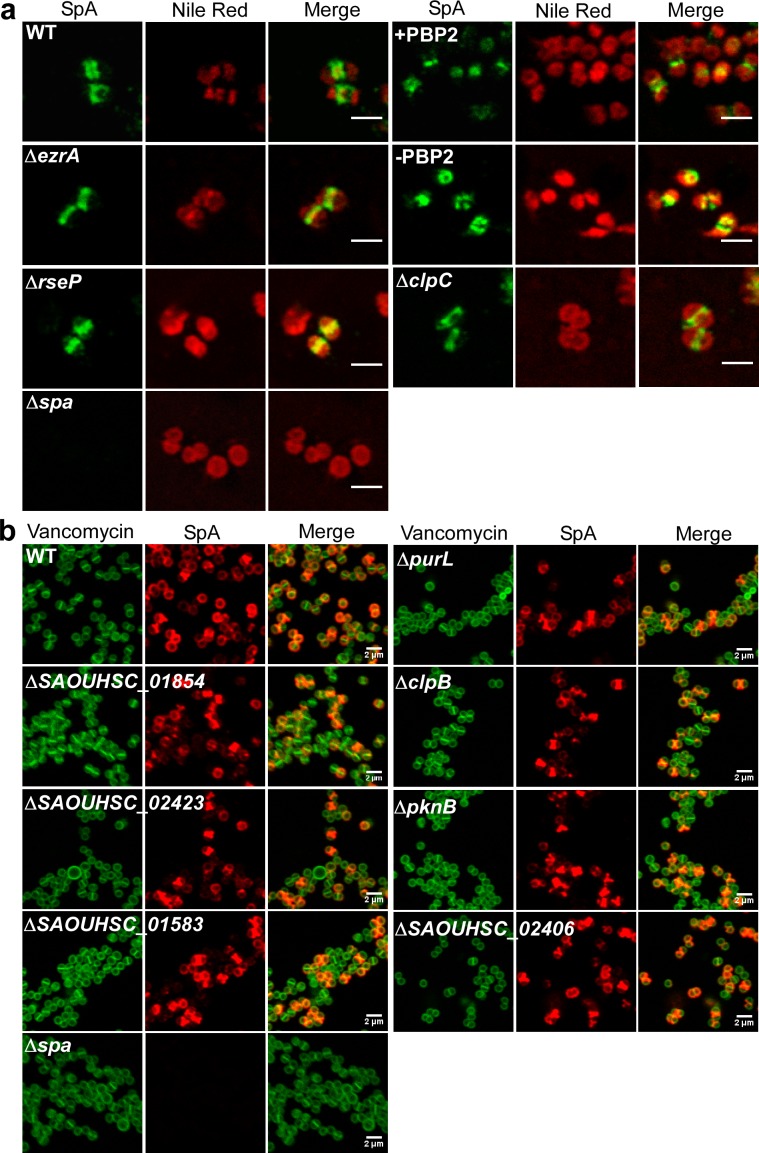
SpA septal secretion analysis in S. aureus mutants with knockout or conditional mutations in genes whose products were crosslinked to SpAED/S18L.(a) Localization of SpA secretion in ΔezrA, ΔrseP, ΔclpC and PBP2-depleted S. aureus. To detect intracellular localization of SpA in mutants with known cell division or peptidoglycan synthesis defects, bacteria were trypsin treated to remove extracellular surface proteins and fixed with para-formaldehyde. Samples were treated with lysostaphin, incubated with detergent and SpA-specific rabbit antibodies and Alexa Fluor 488-labeled goat-anti-rabbit-IgG (green) and with Nile red to reveal bacterial membranes. Scale bar, 2 µm. (b) Localization of newly deposited SpA at the cross-wall in several staphylococcal mutants. To screen for surface protein targeting defects, wild-type staphylococci and the corresponding mutants were treated with trypsin to remove SpA. Bacteria were incubated for 20 min to allow for secretion and cell wall deposition of newly synthesized SpA. Samples were incubated with BODIPY-FL vancomycin (Vancomycin, green) to stain the bacterial cell wall and with SpA-specific monoclonal antibody and Alexa fluor 647-labeled secondary IgG (red) to reveal SpA.